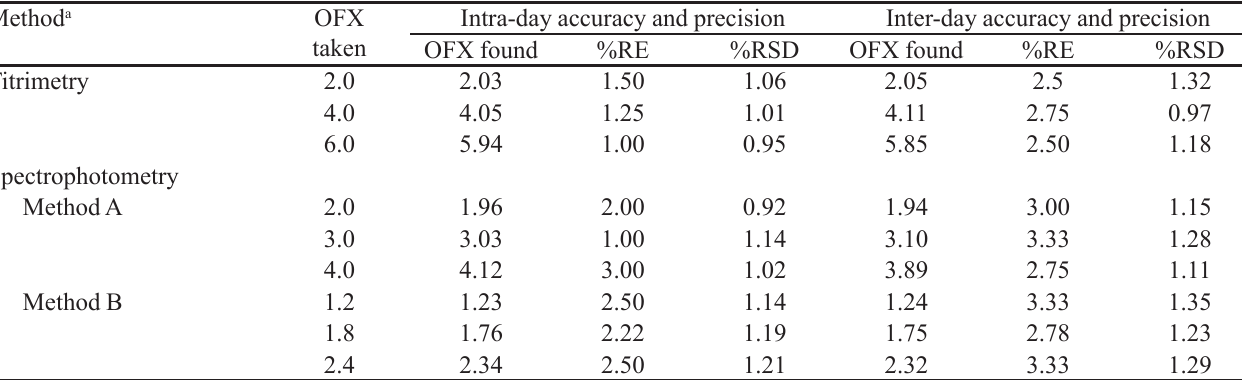
TABLE III - Evaluation of intra-day and inter-day accuracy and precision Method a